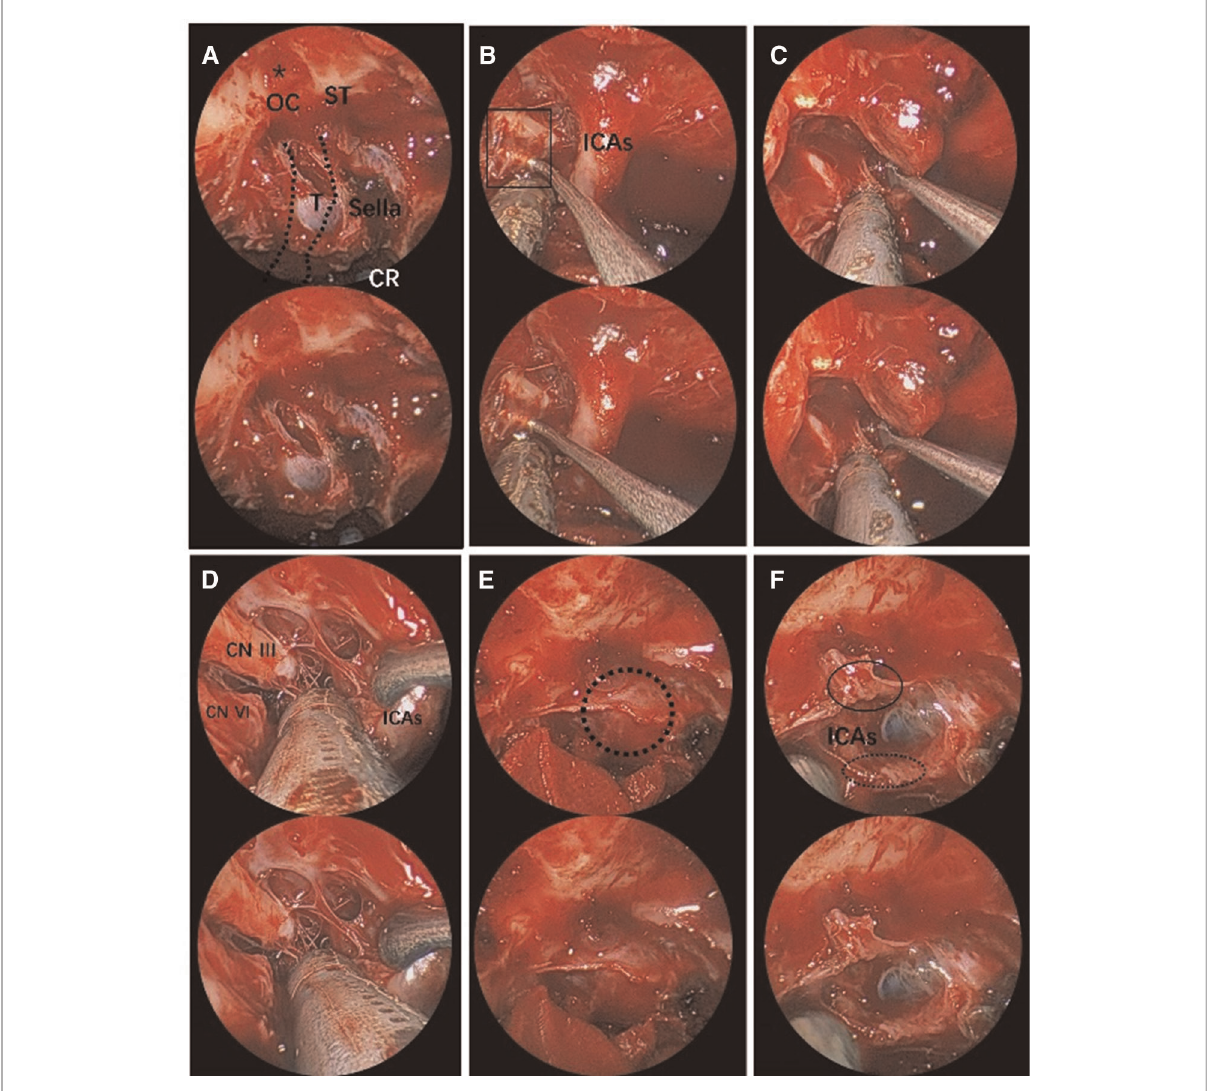
FIGURE 5 Endoscopic visualization of CS pituitary tumor. ( A ) Exposure of the planum sphenoidale and supraoptic recess (black asterisk). The route of the internal carotid artery. The black asterisk represents the supraoptic recess. ( B ) View of the fi ber texture in CS. ( C,D ) Close-up view of the ICAs and nerves, crucial for tumor dissection. ( E ) View of the proximal and distal dural rings of the internal carotid artery (black dotted circle). ( F ) This is the proximal and distal dural ring of the internal carotid artery after resection of the tumor. The black ellipse represents the distal dural ring. The black dotted line ellipse represents the proximal dural ring. The 3D image can be obtained with cross-viewing method. ICAs, intracavernous segment of internal carotid artery; CR, clival recess; CN III, oculomotor nerve; CN VI, abducens nerve; T, tumor; CS, cavernous